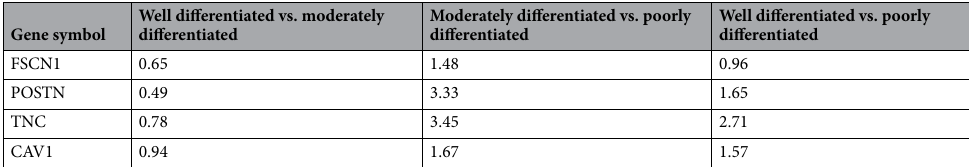
Table 7. Fold change expression of POSTN, TNC, CAV1, FSCN1 in various grades.